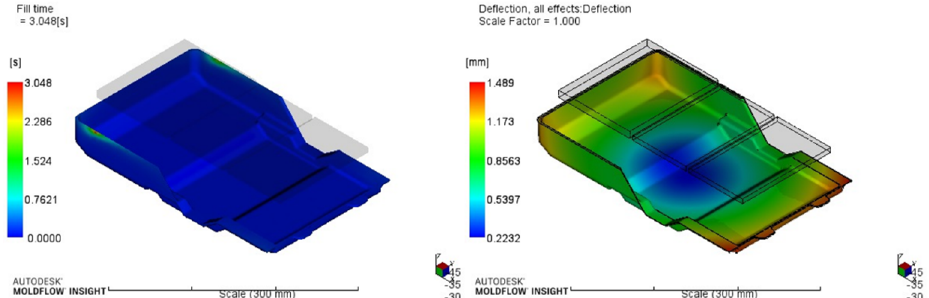
Figure 3. Result of fill time and warpage value for optimal process parameters.